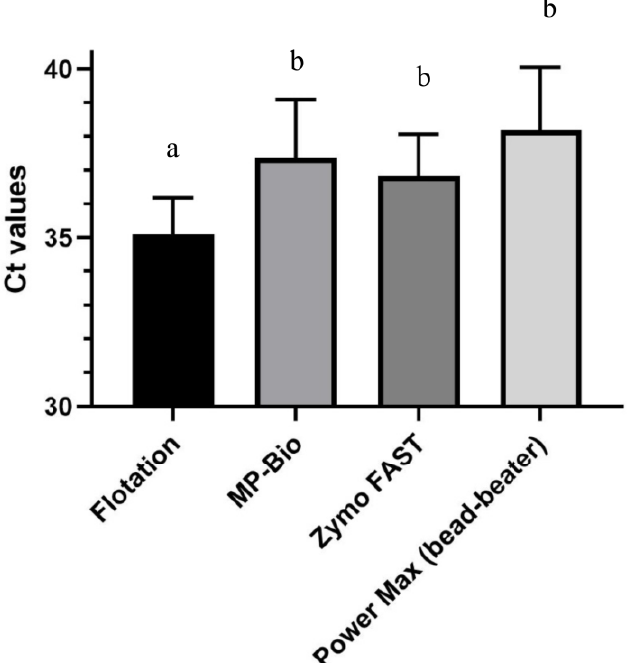
Figure 1. Comparison of average C T values for C. cayetanensis detection in soil samples (10 g) seeded with 100 oocysts after DNA extraction by different methods (Flotation and BAM Chapter 19b Method 1; Fast DNA TM 50 mL SPIN kit for soil (MP Biomedicals) Method 2, Quick-DNA TM Fecal/Soil Microbe Midiprep kit (Zymo Research), Method 3, and DNeasy ® PowerMax ® Soil Kit (Qiagen) using bead-beating, Method 4b). Different letters on top of methods indicate statistically significant differences ( p < 0.05).